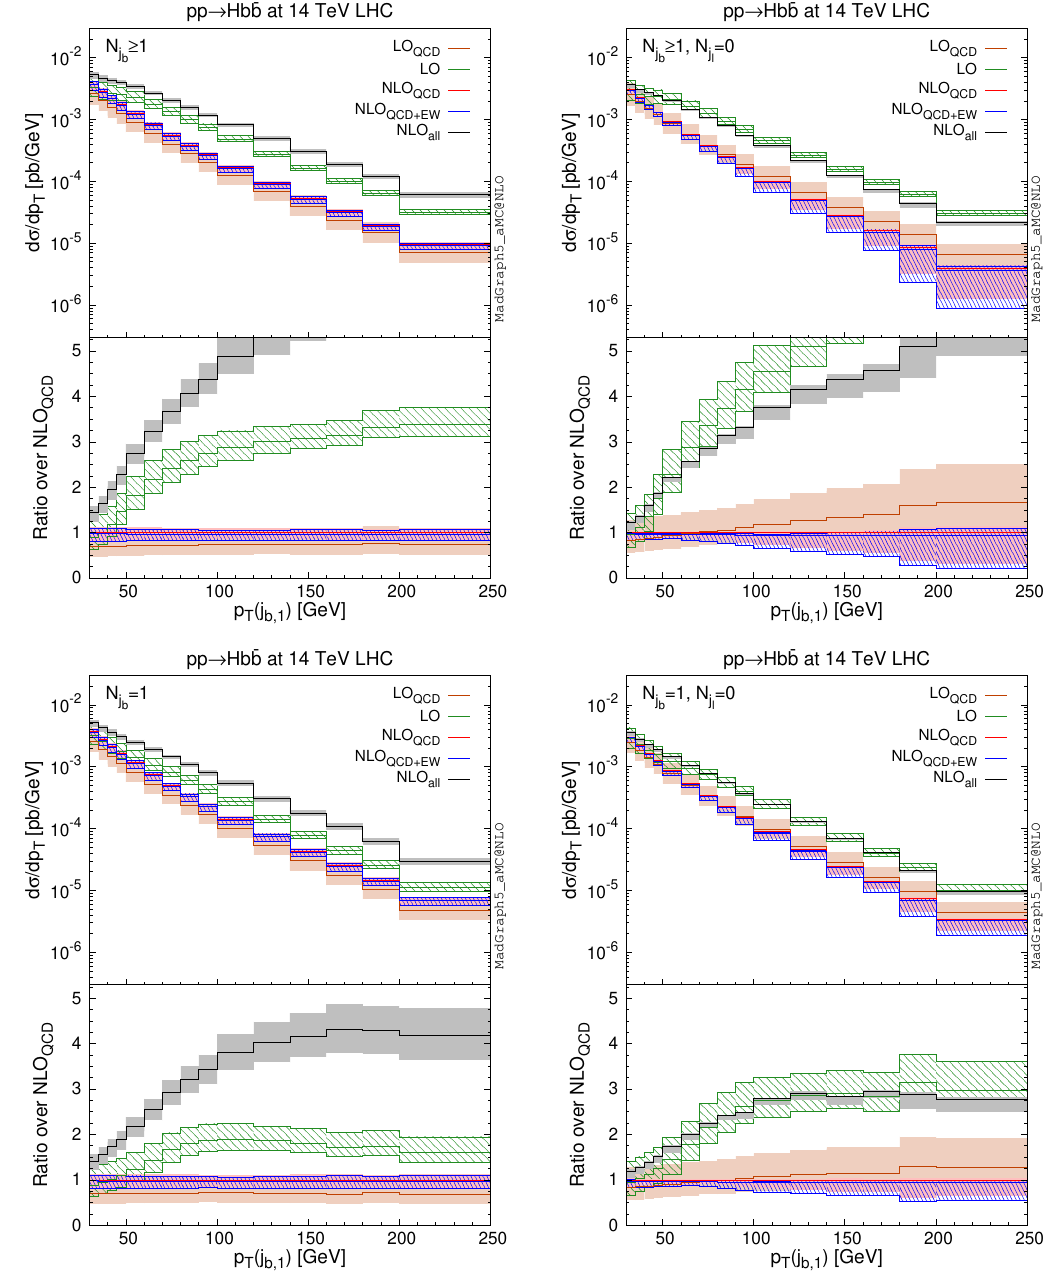
Figure 3 . The p T ( j b, 1 ) distribution for N j light-jet veto is